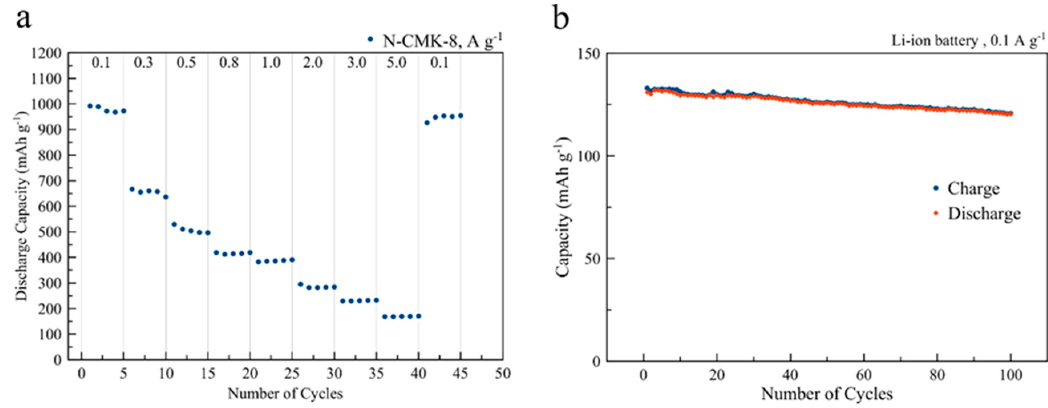
Figure 5. ( a ) Rate capability of N-CMK-8 and ( b ) long term capacity of the Li-ion cell.